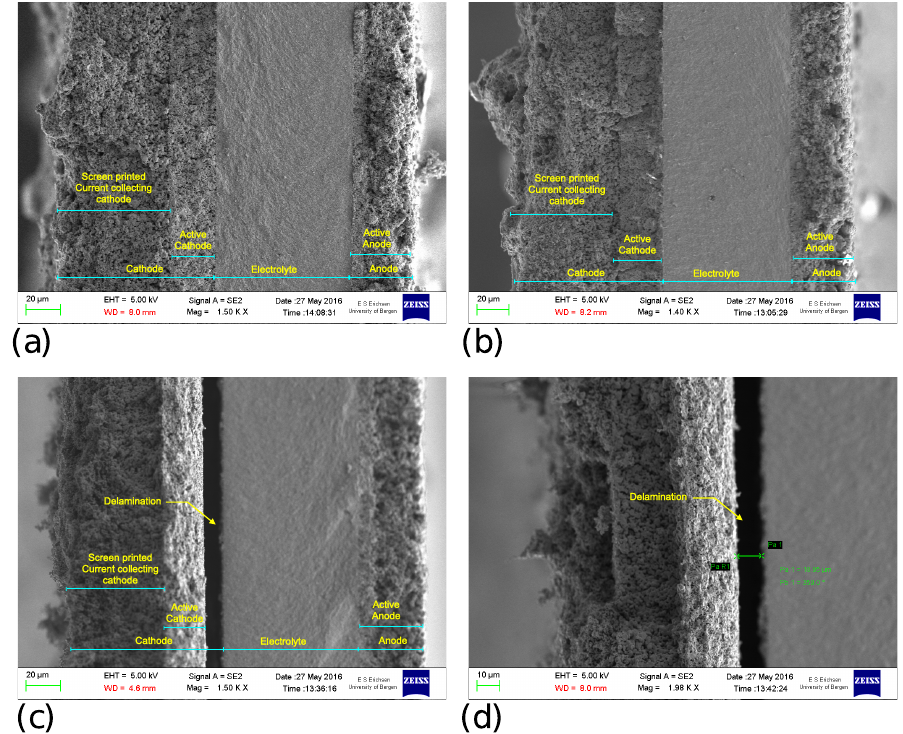
Figure 10. Cross sectional SEM images of the cells after long-term testing at 900 ◦ C. ( a ) Shows the cell in its initial state. ( b ) shows the cell that has been operated for 850 h without salt contamination. ( c ) shows the cell after operation with salt contamination (at 1 ppm) for 660 h, the cell can be seen to have delaminated leading to severe and irreversible degradation. ( d ) shows a detail of the